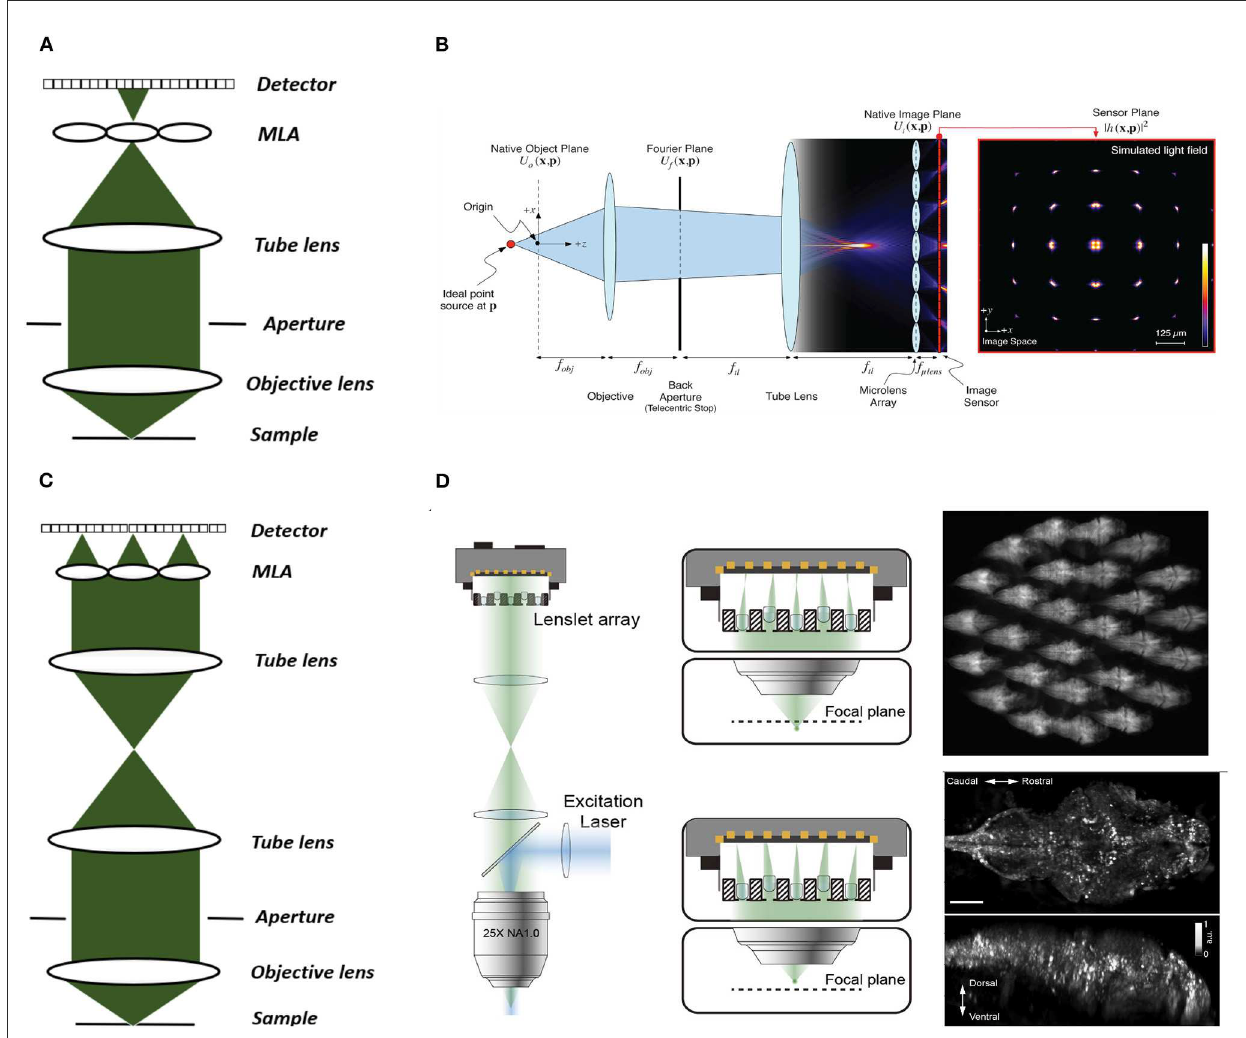
FIGURE3 Conventional and Fourier LFM. (A) Conventional LFM: The MLA is placed at the native image plane, which is conjugated to the native object plane. Each sub-image records the rays emitted from the conjugated point on the object plane at different angles within the numerical aperture of the objective lens. (B) Schematic of wave optics model based on the LFM optical path. The microlens array at the native image plane is modeled as a tiled phase mask operating on this wavefront, which is then propagated to the camera sensor. The x-y cross-section on the far right shows the simulated light field generated at the sensor plane (Broxton et al., 2013). (C) Fourier LFM: The MLA is placed at the Fourier plane to focus the incident light onto the camera plane. Each sub-image is a focused sample image observed from that lenslet’s perspective. (D) Schematic of XLFM. The MLA (lenslet array) position is conjugated to the rear pupil plane of the imaging objective. Point sources at two different depths form sharp images on the imaging sensor, through two different groups of microlenses, with positional information reconstructed from these distinct patterns (reproduced from Cong et al., 2017). (B) reproduced with permission from Broxton et al. (2013) ©The Optical